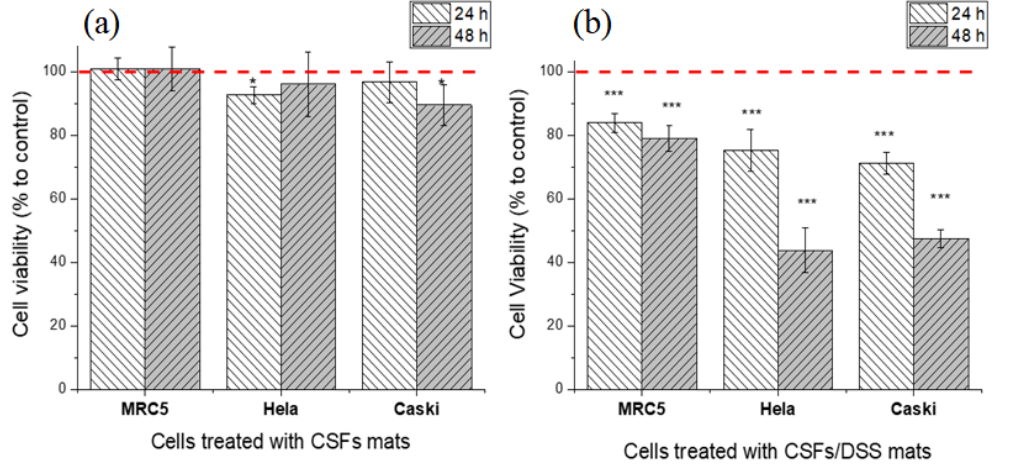
Figure 6. Biocompatibility of CSFs ( a ) and the effect of DSS-loaded CSFs on normal fibroblast (MRC5), Hela and CaSki cells after 24 and 48 h incubation ( b ). The red dashed line corresponds to cell viability of control–untreated cells. Cell viability was determined by MTT assay. The results for the biocompatibility of CSFs ( a ) are presented as mean ± SD (n = 4) and for anti-cancer activity ( b ) as mean ± SEM of three independent experiments. The statistical significance is shown by asterisks (* p < 0.05, *** p < 0.001).